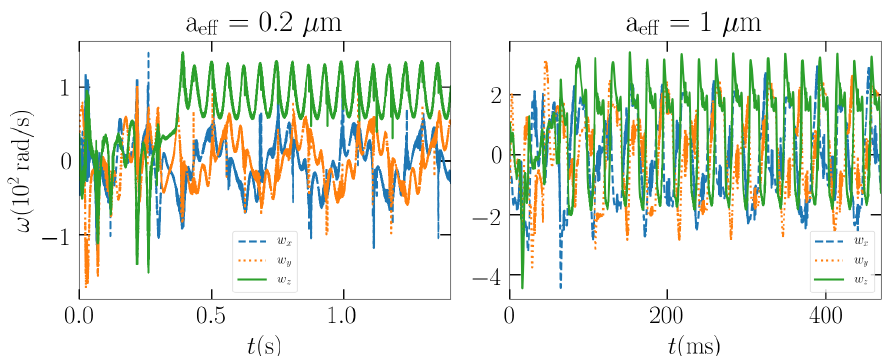
Fig 17. The angular velocities in the laboratory frame of the 0.2 and 1- μ m particles in the Laguerre-Gaussian (LG 03 mode) beam,